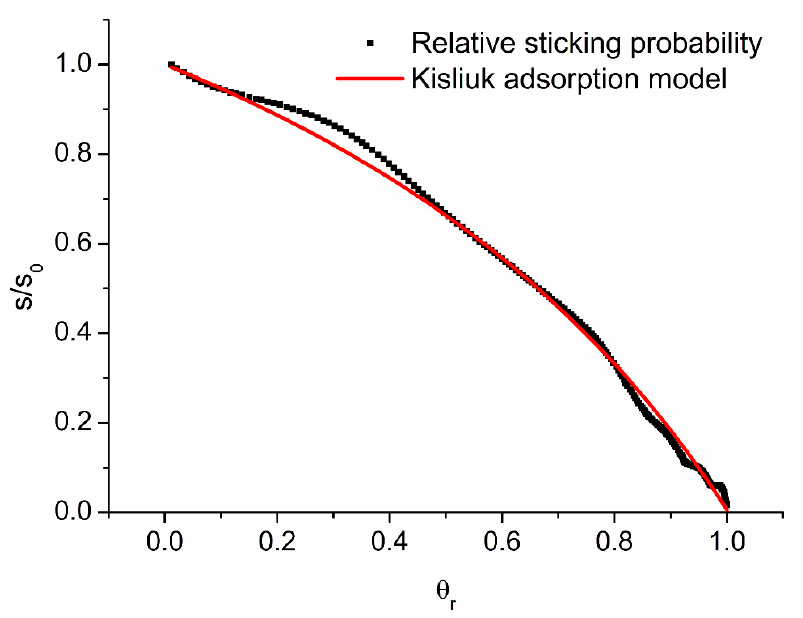
Figure 8. Plot of relative sticking probability s / s 0 versus relative coverage θ for CO sticking at 450 K (solid line). The corresponding Kisliuk fit is shown as a red line.